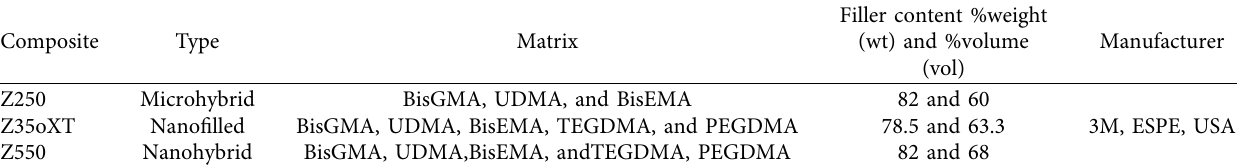
Table 1: Composition, type, and manufacturer of composite